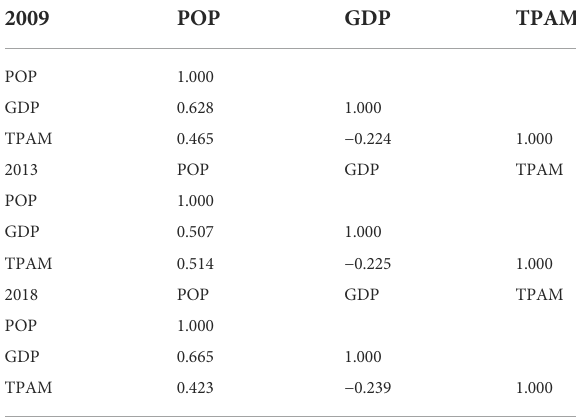
TABLE 6 Correlation coef fi cient of independent variables.